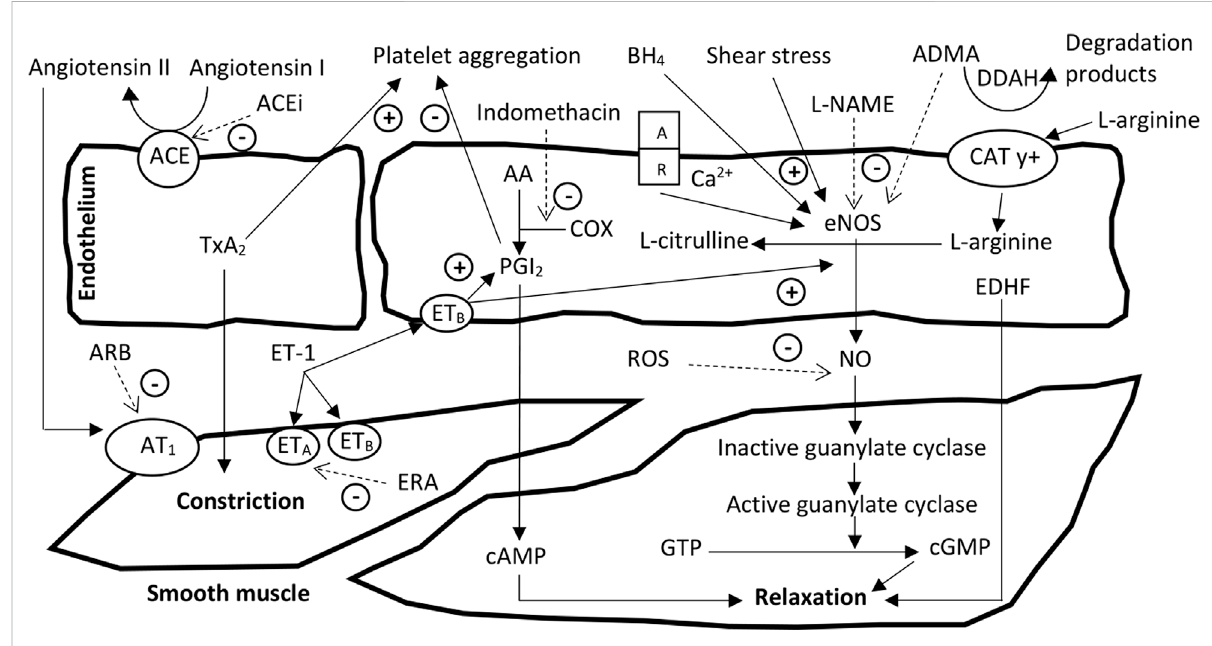
FIGURE 3 Majorsignalingpathwaysinvolvedinendothelialandvascularsmoothmusclefunction.Cationicaminoacidtransporter-y+regulatesuptakeof L -arginine substrate into the endothelial cell. Agent A, acting on receptor (R) of the endothelial cell activates Ca 2+ in fl ux: for example, acetylcholine (ACh) acts on the endothelial muscarinic (M 3 ) receptor causing Ca 2+ in fl ux. The increase in intracellular Ca 2+ leads to activation of endothelial nitric oxide synthase (eNOS). Shear stress or substrate supplementation of tetrahydrobiopterin (BH 4 ) can increase activation of eNOS while the latter is inhibited by asymmetric dimethylarginine (ADMA). Nitric oxide (NO) endothelial derived relaxing factor (EDRF) then diffuses to the smooth muscle cells where it activates guanylate cyclase, which results in an increase in cyclic guanosine monophosphate (cGMP), and thus initiates processes leading to relaxation. N ω -nitro- L -arginine methyl ester ( L -NAME) is a NOS inhibitor, and reactive oxygen species (ROS) act as NO scavengers. Endothelin is an endothelium-derived peptide, which causes vascular contraction via smooth muscle endothelin A and B receptors (ET A and ET B ) or relaxation via endothelial ET B . Arachidonic acid (AA) is a membrane phospholipid that gives rise to prostanoids via cyclooxygenase (COX). Prostacyclin I 2 (PGI 2 ) and thromboxane A 2 (TxA 2 ) are prostanoids. The former causes vascular relaxation and inhibits platelet aggregation, while the latter produces the opposite of these effects. COX can be inhibited by nonsteroidal anti-in fl ammatory drugs like indomethacin and thus inhibit prostanoid formation. Angiotensin converting enzyme (ACE) produces angiotensin II (Ang II); Ang II can cause smooth muscle contraction via